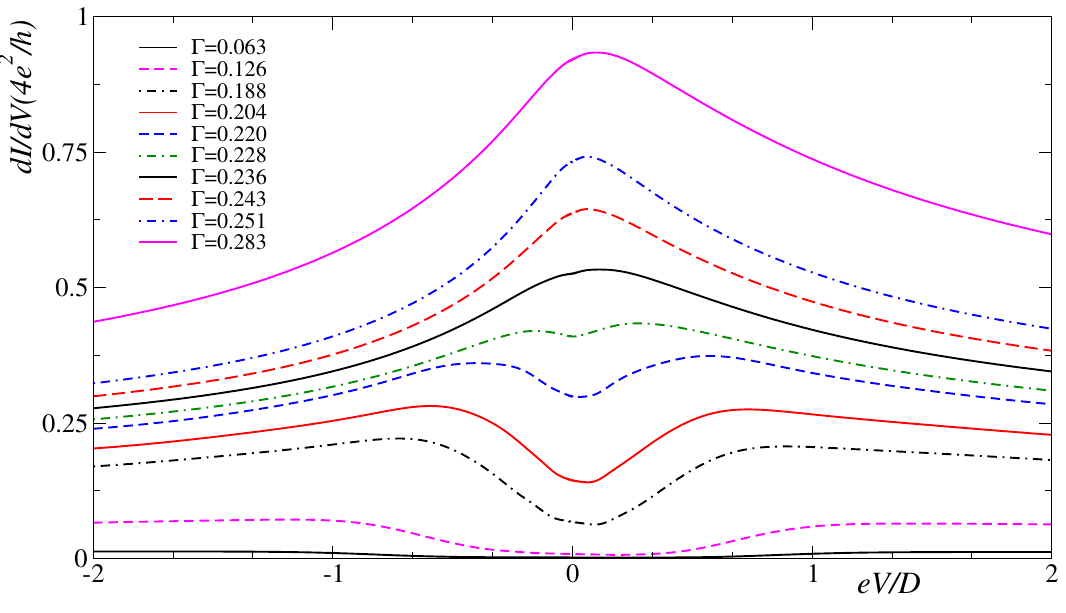
Figure 3: Differential conductance as a function of voltage for different values of Γ . Other parameters are U = 3.5, U ′ = 2.5, J